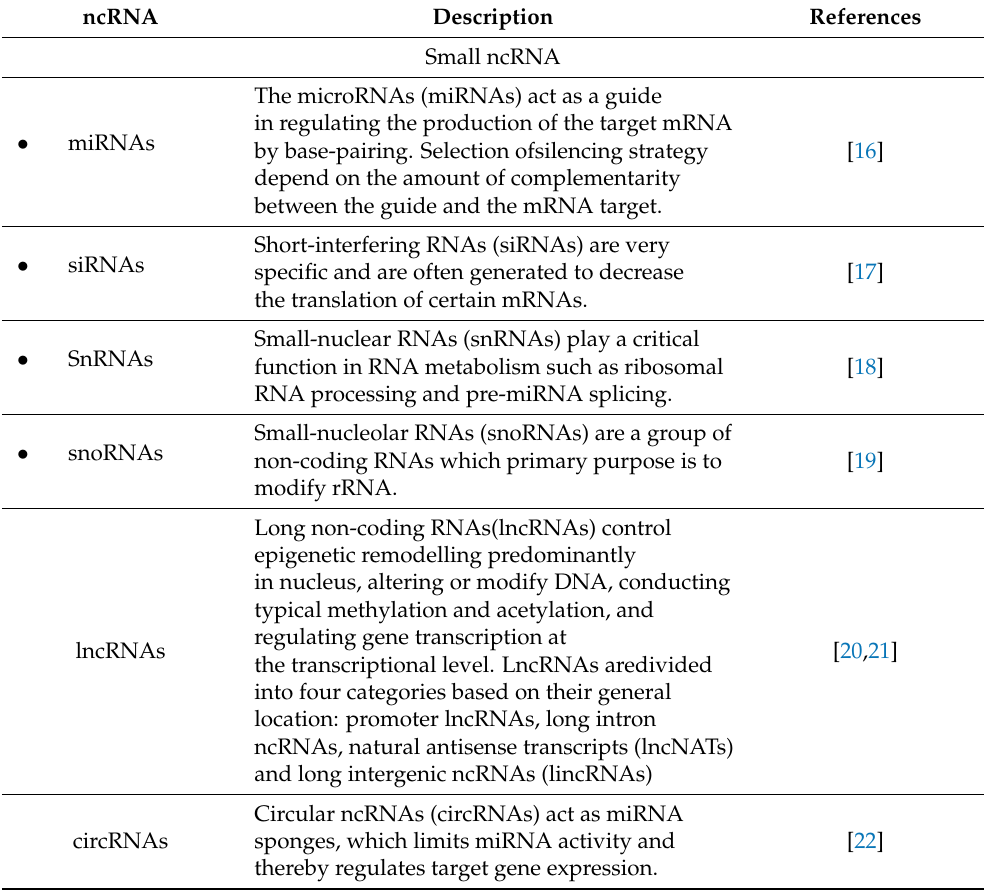
Table 1. ncRNA category and their respective